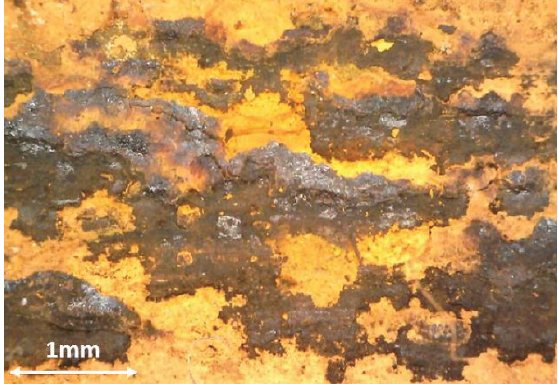
Figure 1. Optical image of the corroded surface of ring AT-C. Table 2. Summary of the mechanical loadings for both tested rings (AT and AT-C).